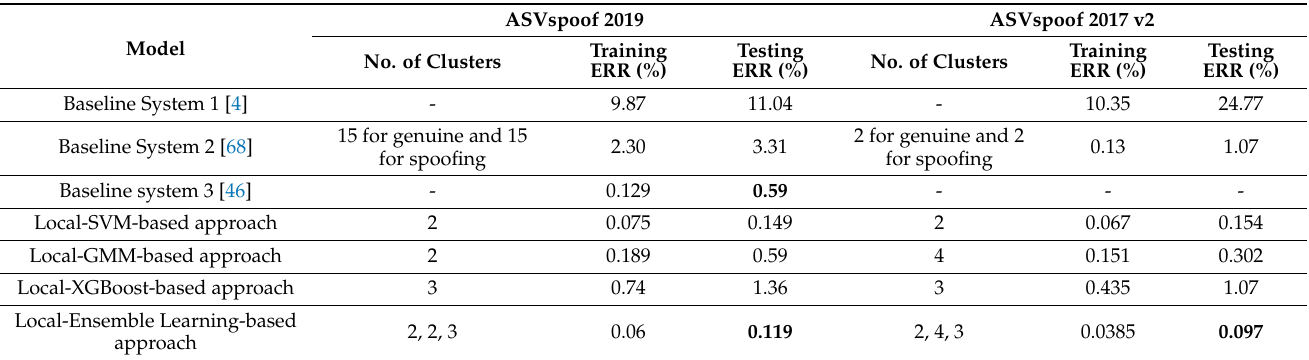
Table 10. Performance comparison with state-of-the-art